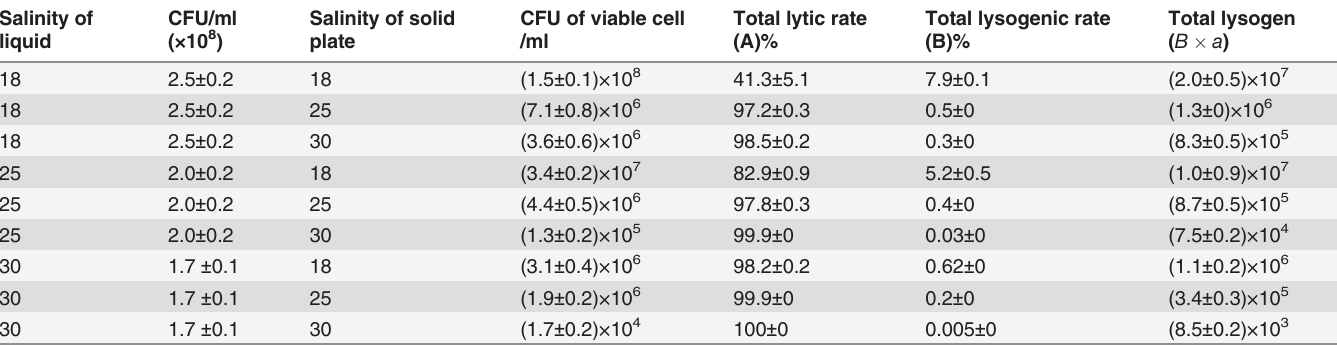
Table 1. Regulation of the replication cycles of halovirus SNJ1by salinity (w/v, %).